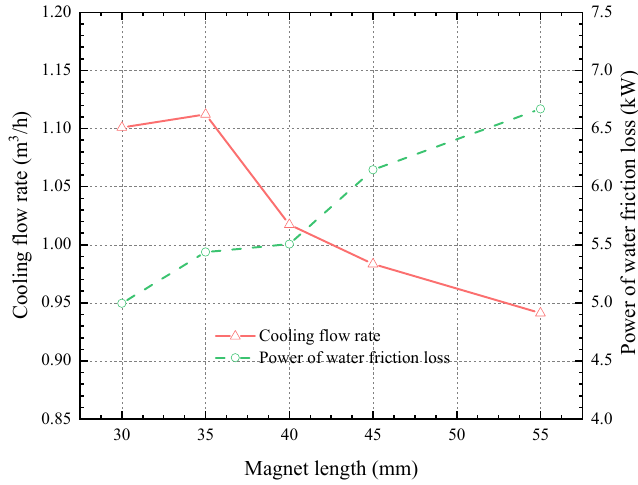
Figure 18. Cooling flow rate and water friction loss of different schemes.